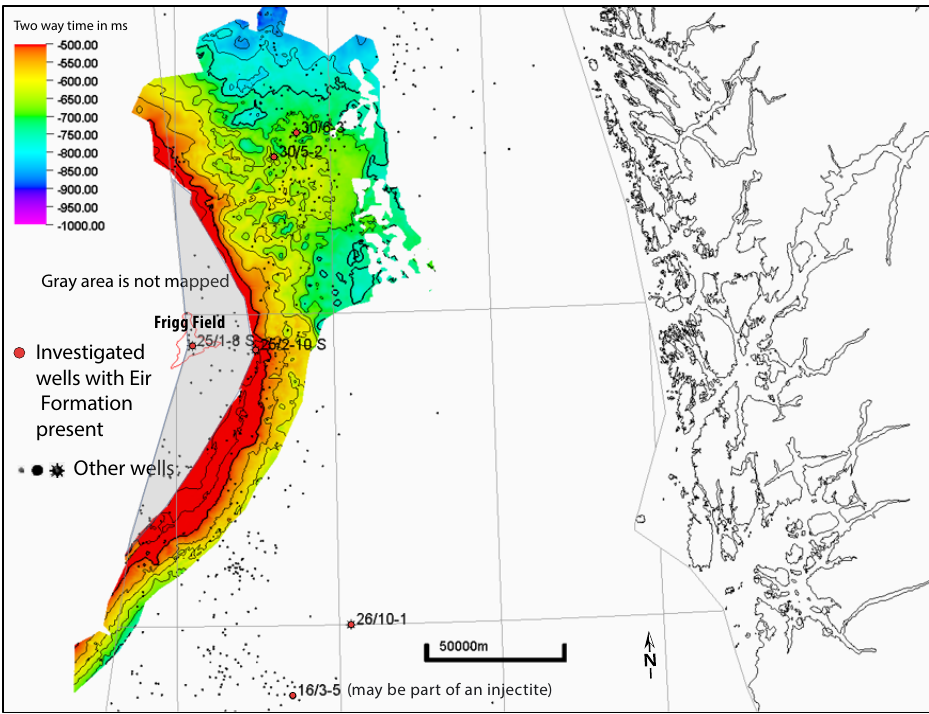
Figure 57. Map showing the extent of the Eir Formation of the Utsira Group and the depth to the top of the formation. Isolated deposits of mid Miocene sandy sediments probably belonging to the Eir Formation are recorded in wells 15/9–13 and 15/3–5 southwest of the area covered by the map in Fig. 57 (see map in Fig.